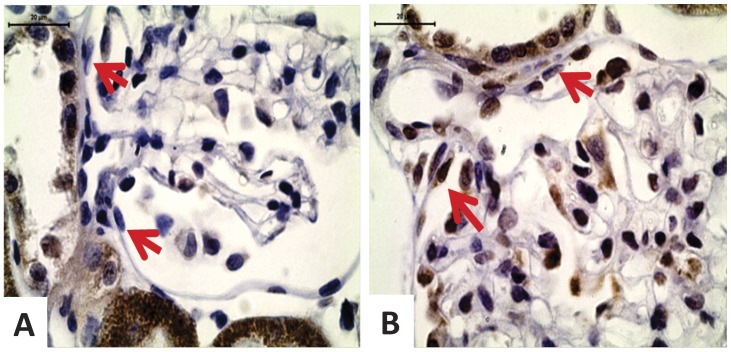
Immunohistochemistry showing enhanced glomerular expression of ZEB 2, an EMT-related mediator.In NP (n = 5), we verified little immunoreactivity for ZEB2 in podocytes and none in PECs (A). In LP (n = 5), both podocytes and PECs (arrows) in the vascular stalk present intensive reactivity (B).